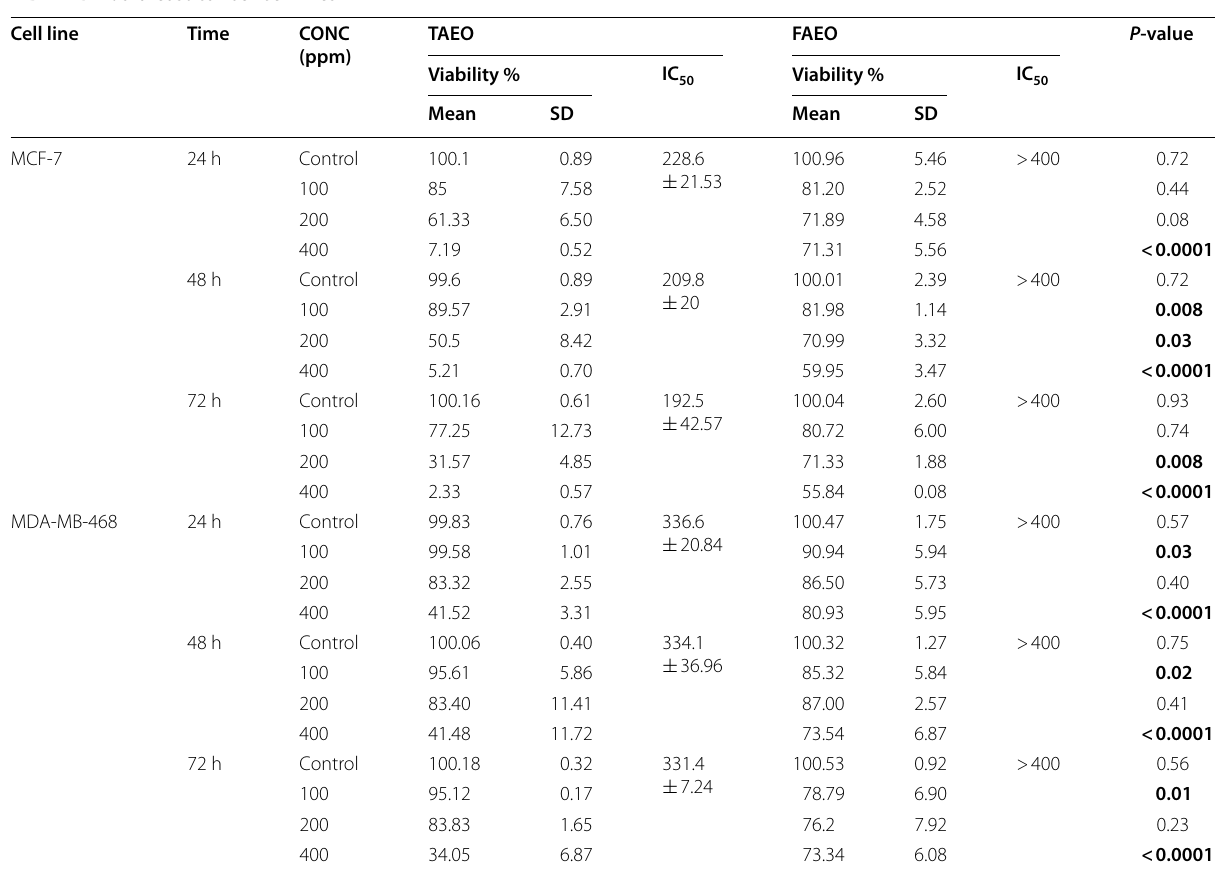
Table 4 Cytotoxic effects of Trachyspermum ammi essential oil (TAEO) and Ferula assafoetida essential oil (FAEO) on MCF-7 and MDA-MB-468 breast cancer cell